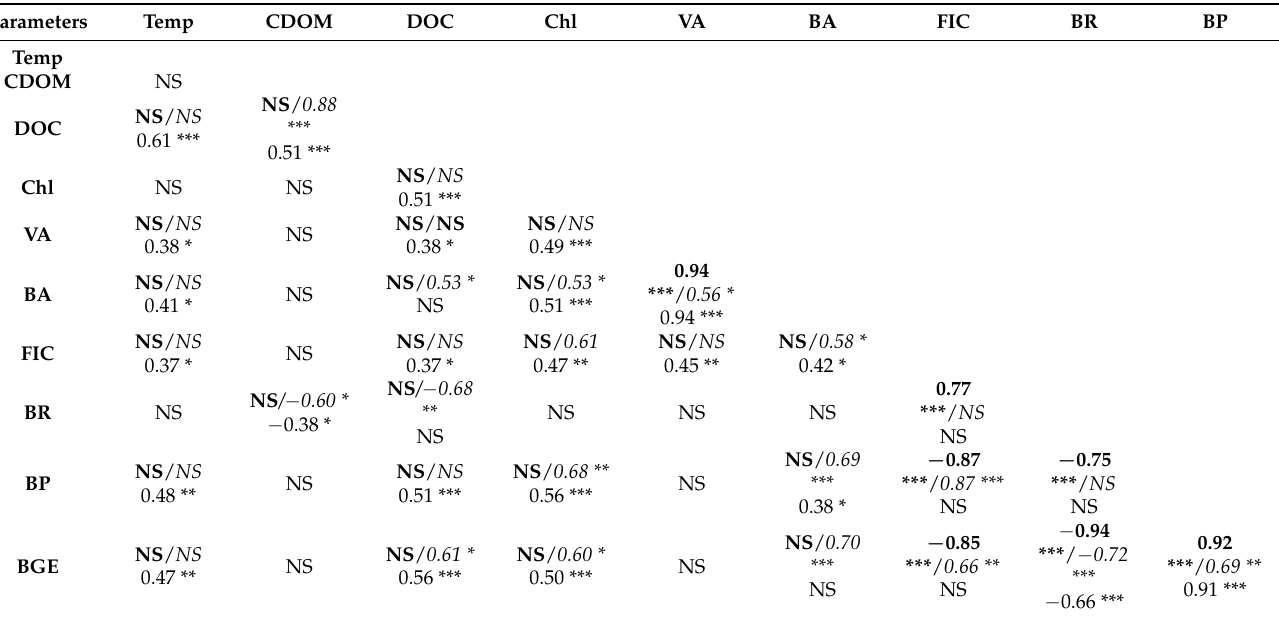
Table 2. Correlation matrix (Pearson r) between the key environmental (abiotic and biotic) variables. Values in bold, italics and in normal text represent eutrophic (n = 13), non-eutrophic (n = 12) and total lakes (n = 25),